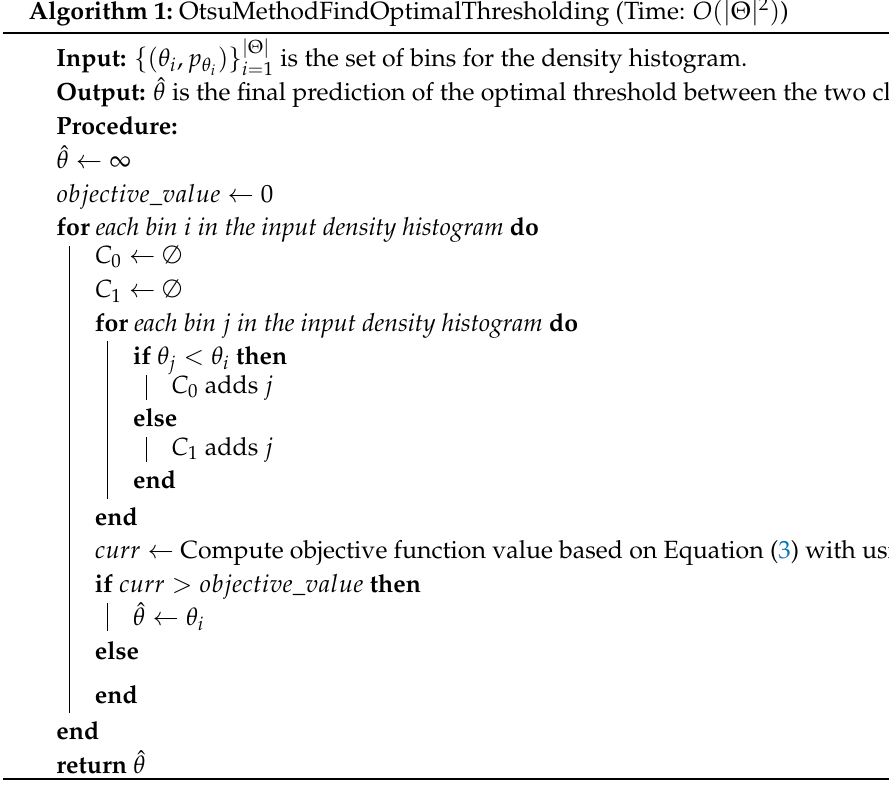
Algorithm 1: OtsuMethodFindOptimalThresholding (Time: O ( | Θ | 2 )